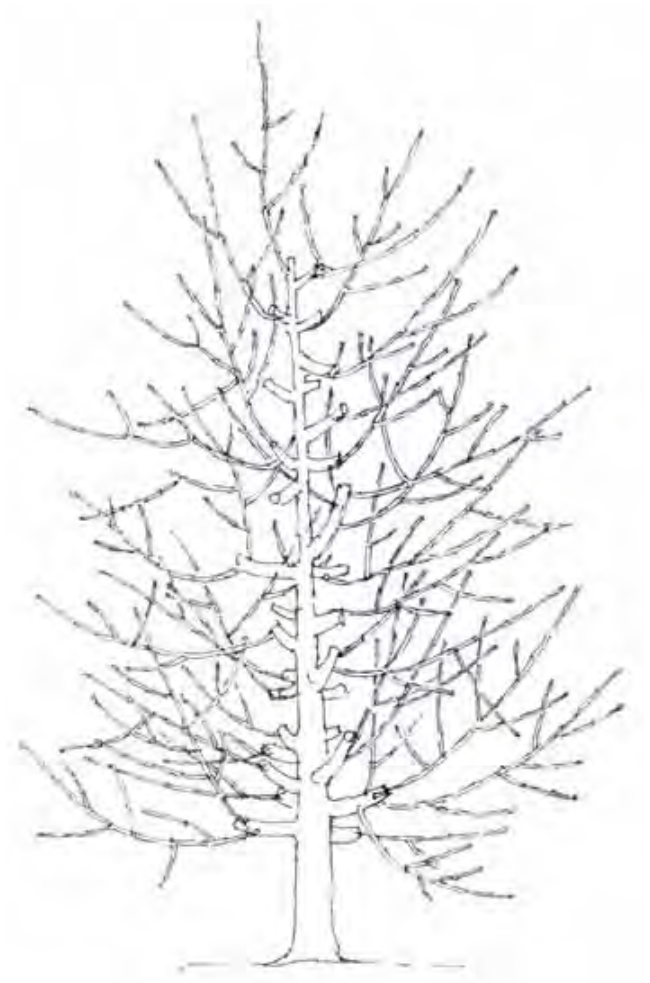
Fig. 2 - Plum tree pruning by renewal method done after harvesting. Old branches are removed to stumps and mainly one-, and two- year-old twigs are